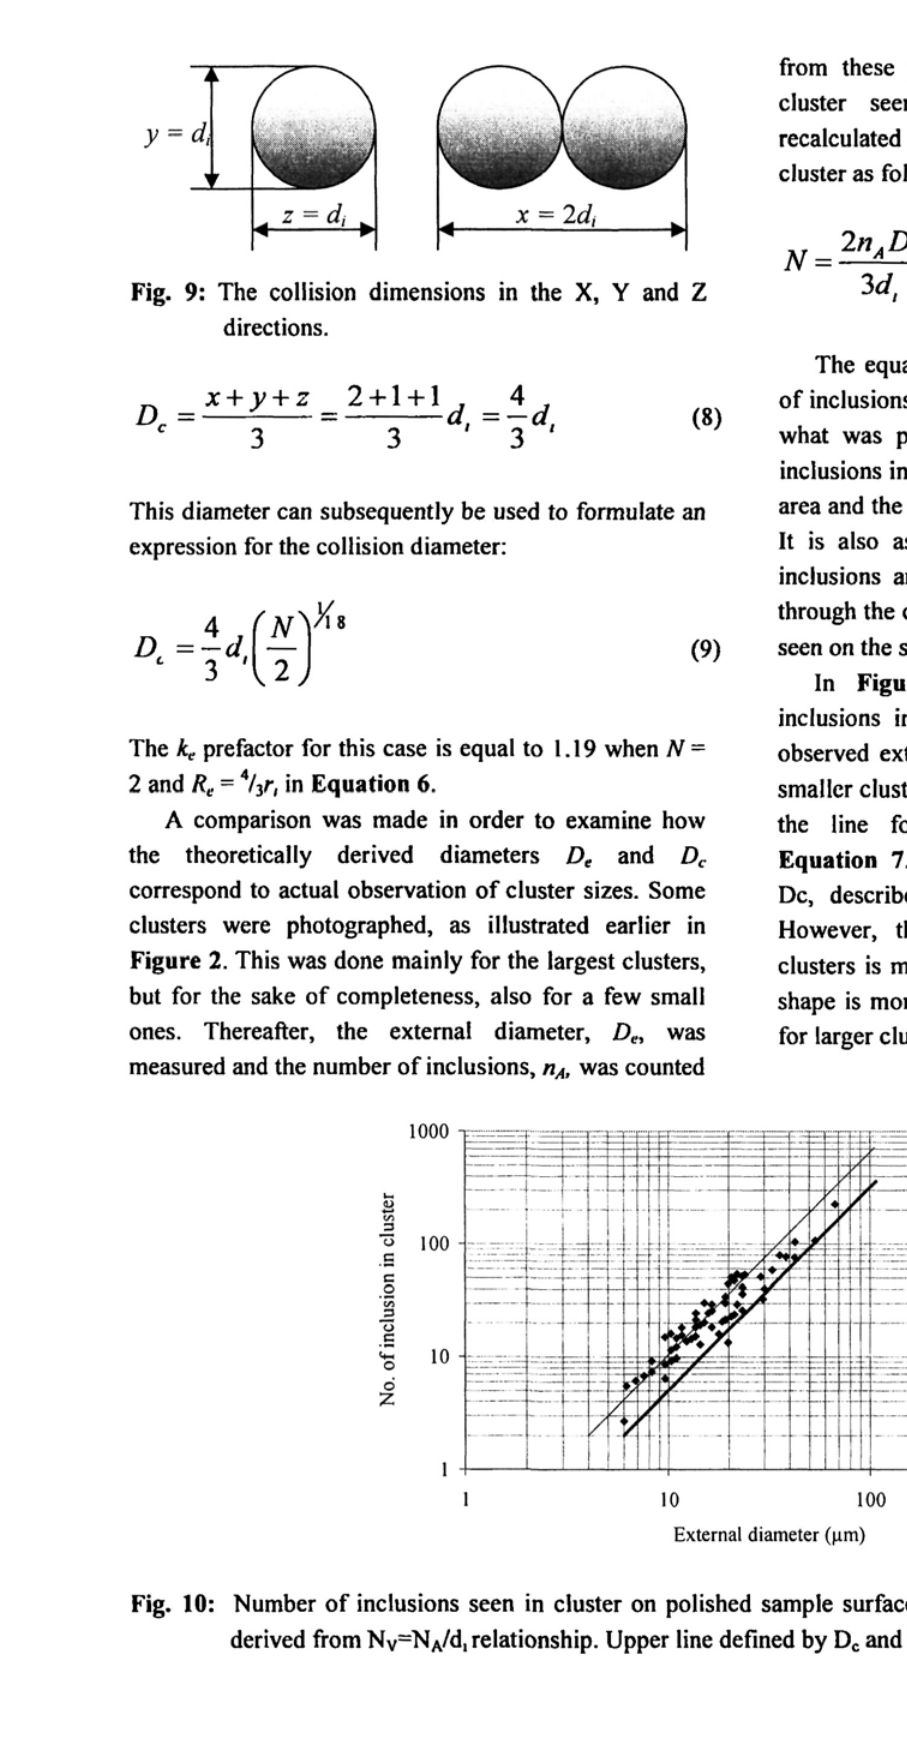
and lower (bold) by D c e